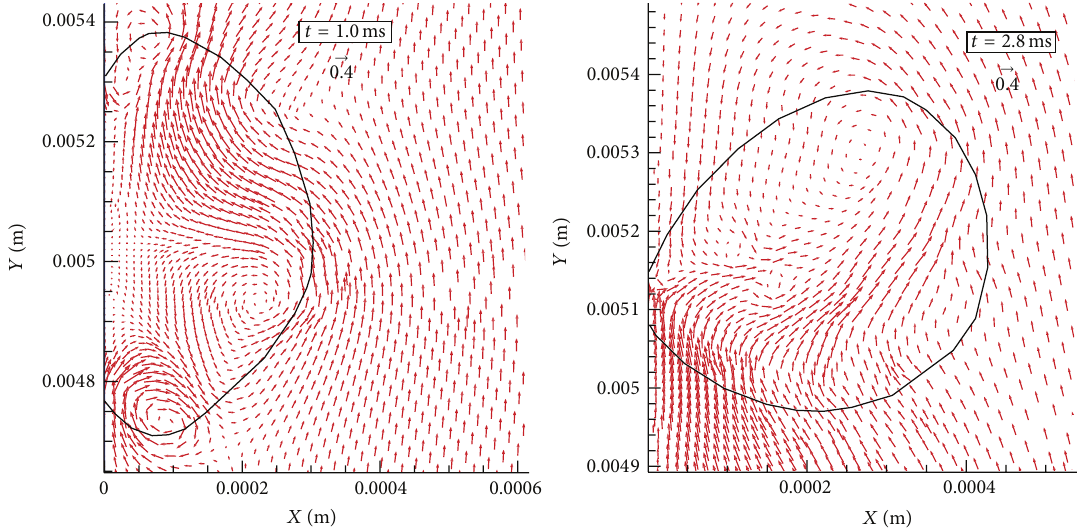
Figure 9: The velocity field distribution on case 1 .